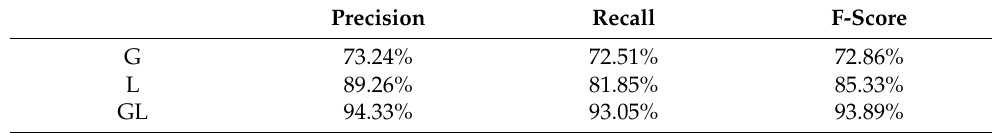
Table 3. Evaluation indicators for different input patch pairs on